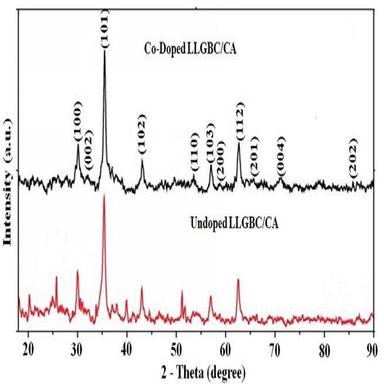
Exposed XRD pattern of pure and Co-doping L-LGBCAC.